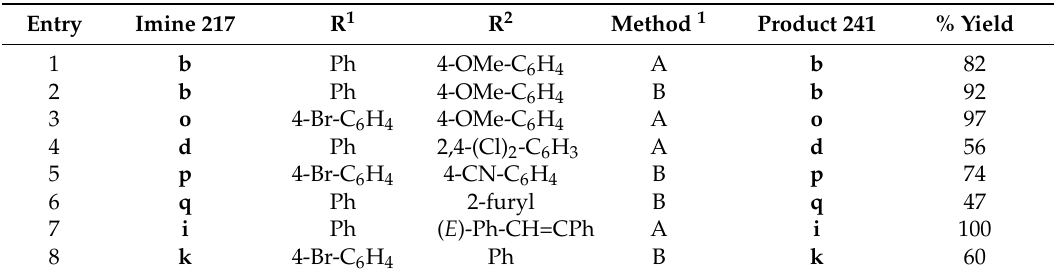
Table 33. Intramolecular cycloaddition of dichlorocarbene derived ylides and ester carbonyl 5e yielding epoxybenzodiazepinones 241 (Scheme 71) 1